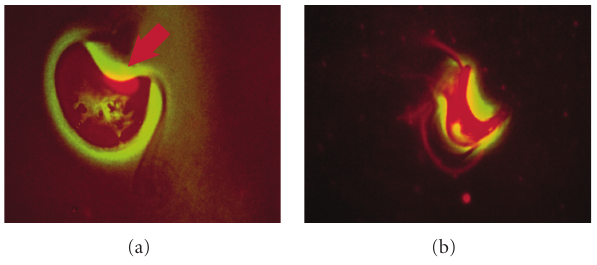
Figure 9: Phase contrast and fluorescent microscopy of Cryptobia salmositica after exposure to isometamidium chloride. (a): Exposure to drug only, note accumulation of drug (in red) in the kinetoplast; (b): exposure to drug conjugated to polyclonal antibodies from a recovered fish, note that the drug (in red) is throughout the organism (reproduced from Ardelli and Woo